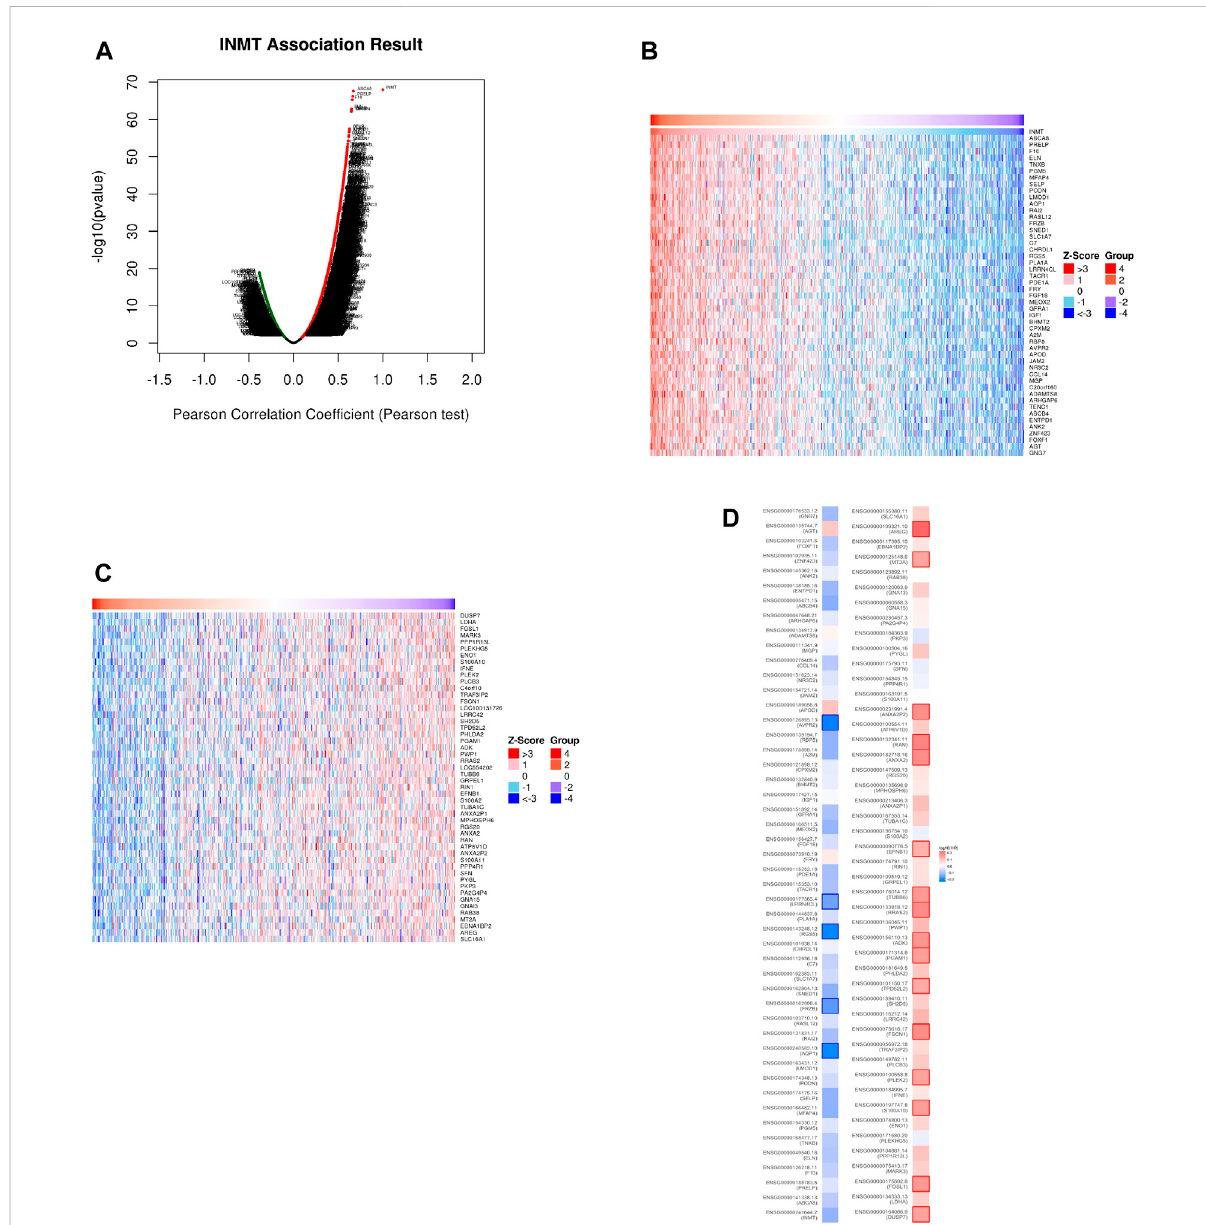
FIGURE 4 The co-expression genes for INMT in HNSC are derived from the LinkedOmics. (A) All the signi fi cantly associated genes with INMT were distinguished by the Pearson test in the HNSC cohort. (B,C) Heat maps depicting the 50 most signi fi cant genes positively and negatively associated with INMT in HNSC. Genes that are positively related are outlined in red, whereas genes that are negatively related are outlined in blue. (D) Survival map of the 50 most signi fi cant genes positively and negatively related to INMT in